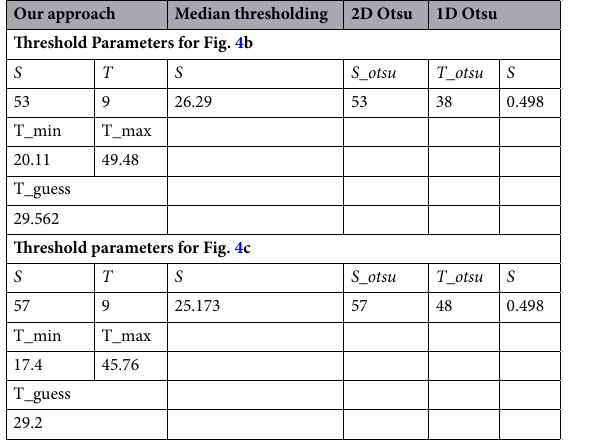
Table 1. Threshold parameters for Figs.